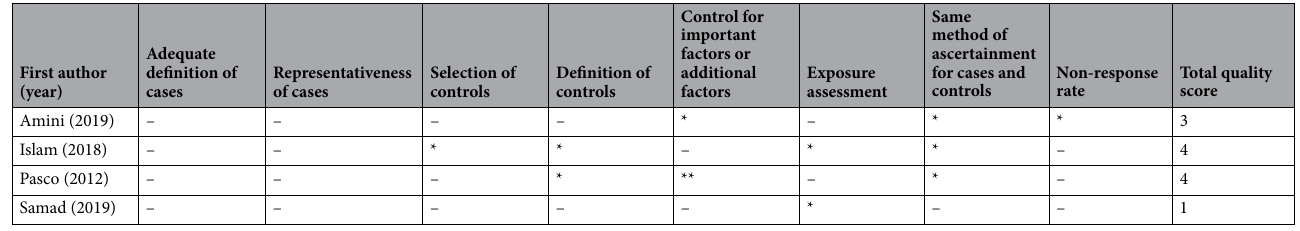
Table 3. Quality assessment of the included case–control studies according to the Newcastle–Ottawa Scale.